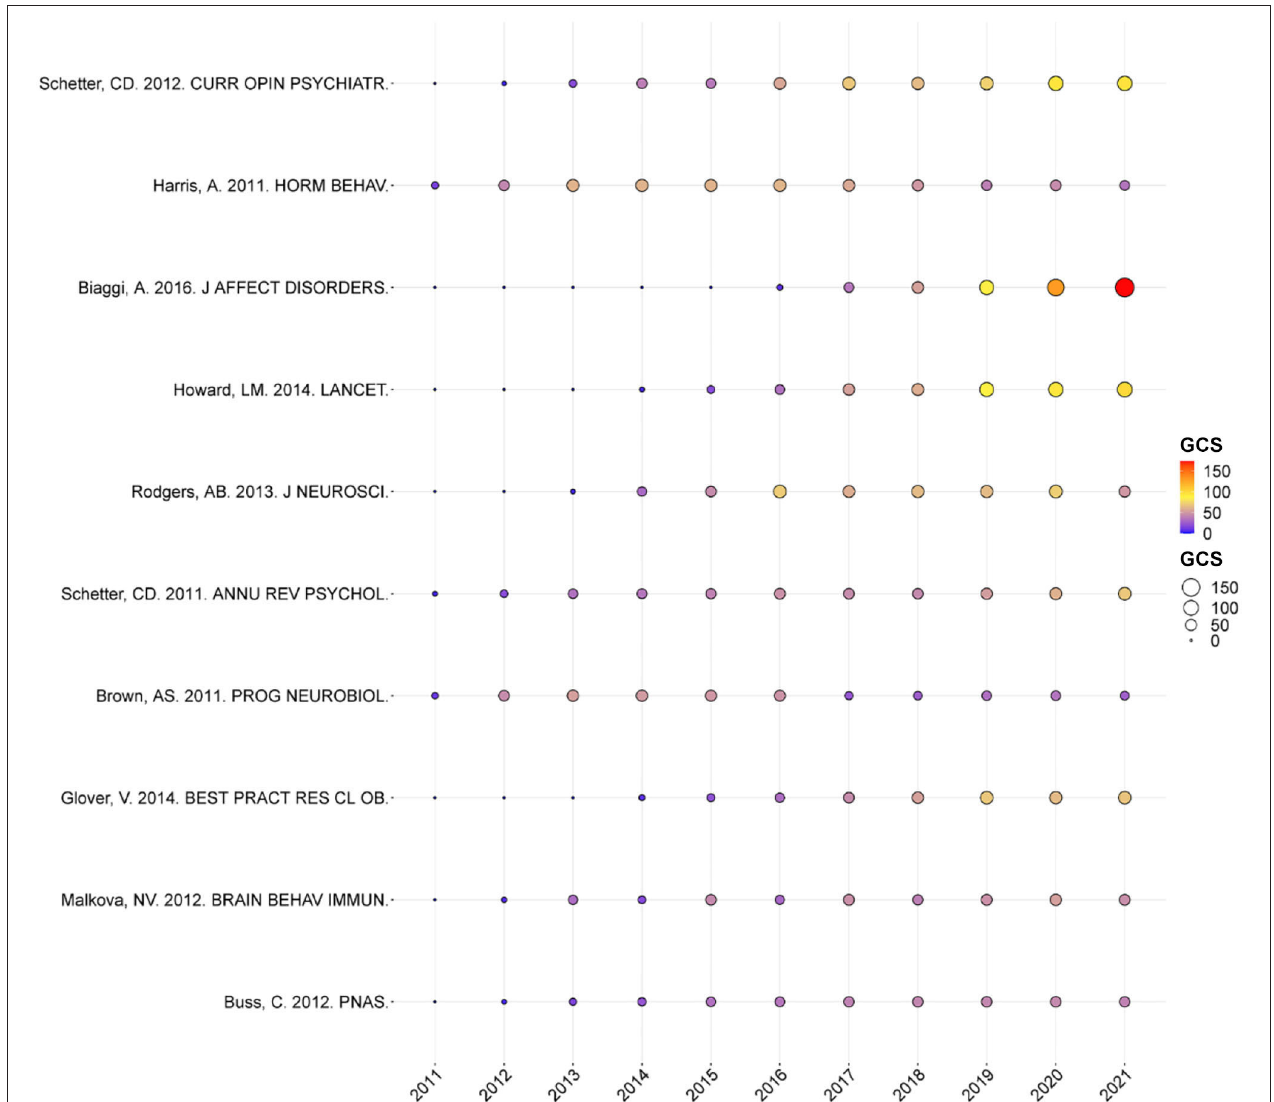
FIGURE 5 | Yearly number of global citations of articles with high global citations (GCS). The GCS of each article is shown by the size and colors of the circle.